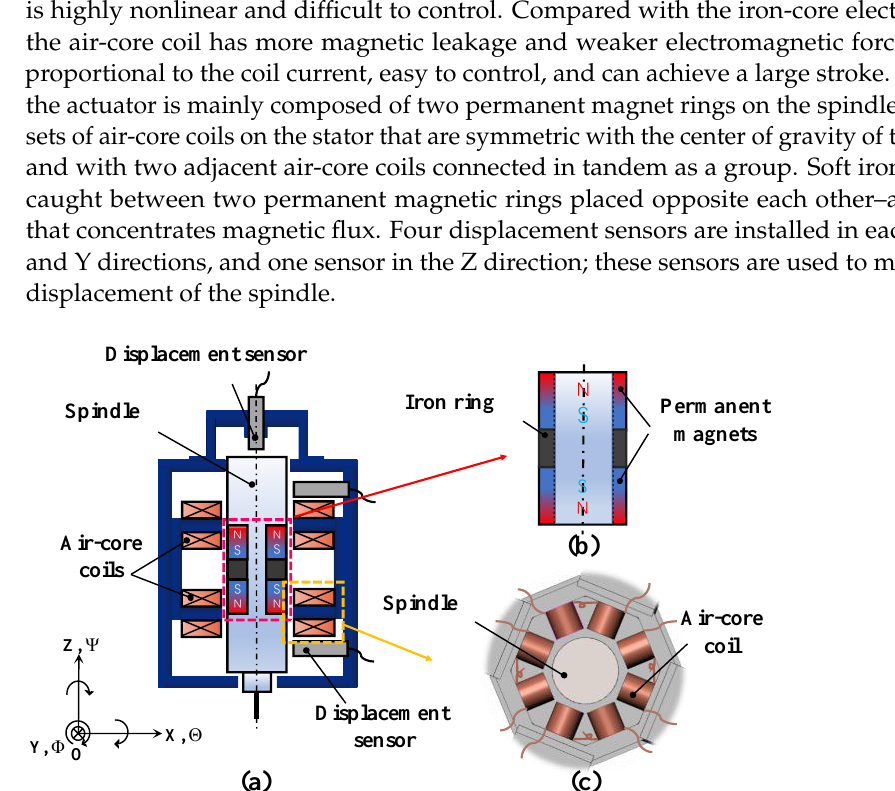
( c ) Figure 2. Principle of spindle motion control. ( a ) X direction; ( b ) Φ direction; ( c ) Z direction. 2.3. Mathematical Model of 5-DOF Magnetic Levitation Actuator The equations of motion in the Z, X, and θ directions of the spindle are shown in Equations (1) – (3). The equations of motion in the Y and Φ directions are the same as those in the X and θ directions, so they are omitted.